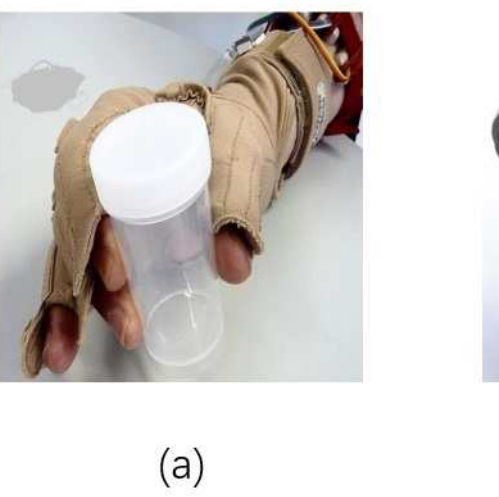
Figure 8. A brain controlled robotic glove. ( a , b ) is reprinted from